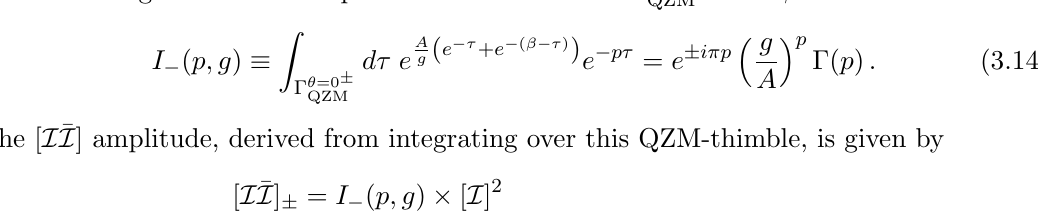
= (cid:12)= 2. As (cid:12) ! 1 , 0 in the (cid:12) ! 1 limit results QZM